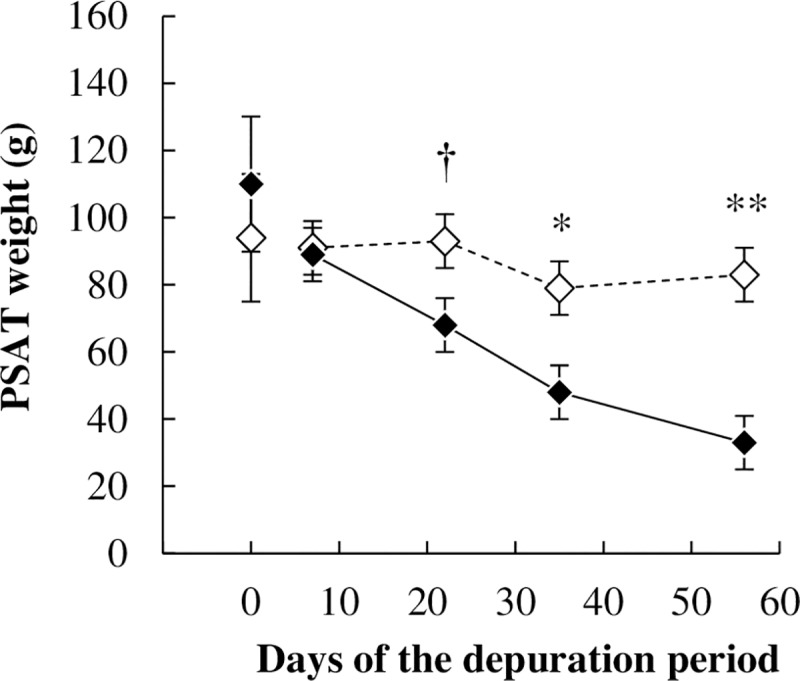
Time pattern kinetics of pericaudal subcutaneous adipose tissue (PSAT) weight in ewes receiving a control well-fed and non-supplemented treatment (CTL: ◊) or an underfed and mineral oil supplemented treatment (UFMO: ♦).Each point represents the least-squares mean, and error bars indicate SEM except at day 0, for which they represent the mean and SE. The * and ** symbols indicate a significant (P ≤ 0.05 and P ≤ 0.01, respectively) and † a tendency toward significance (P ≤ 0.10) for treatment effect on the considered day.